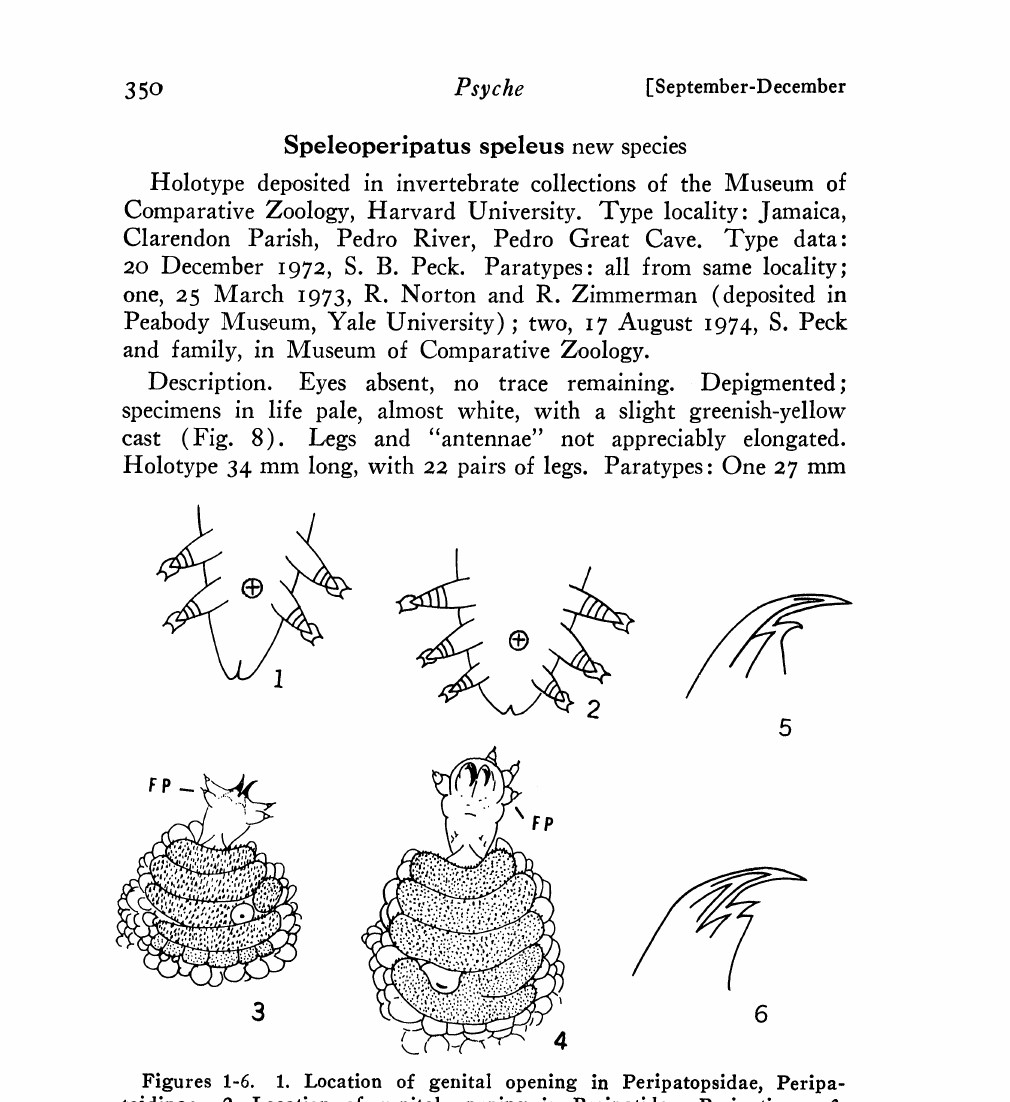
Figures 1-6. 1. Location of genital opening in Peripatopsidae, Peripa- toidinae. 2. Location of genital opening in Peripatidae, Peripatinae. 3. Ventral surface of left fourth leg of Oroleri#atus koe#ckei (after Zilch, 1954b) showing urinary papilla dividing the third band of the creeping pads, and four foot papillae (fp). 4. Ventral side of right fourth leg of Heteroleri/mtus engelhardi (after Zilch, 1954a) showing urinary papilla . between creeping pads three and four, indenting pad four, and three anterior and one posterior foot papillae (fp). 5. Outer blade of right mandible of Sleleo#eri/mtus s#elaeus. 6. Inner blade of right mandible of